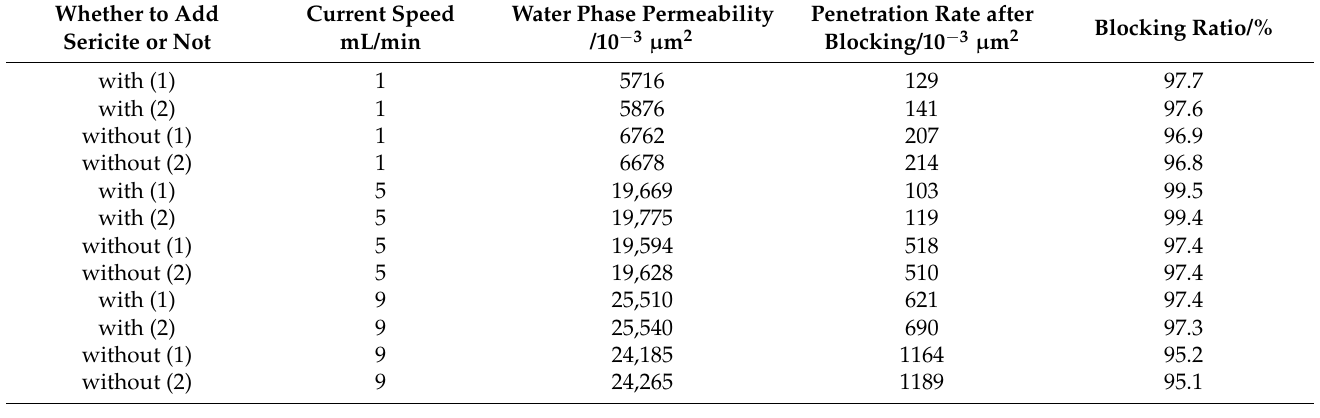
Table 2. Blocking performance of plugging agent.